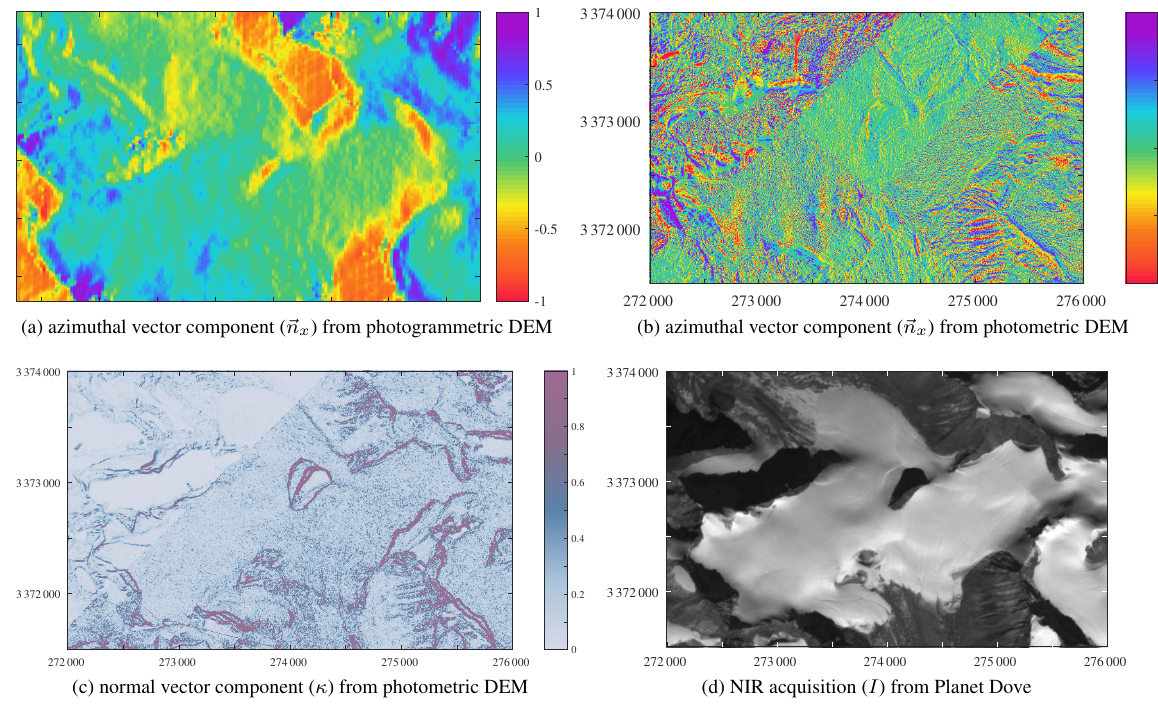
Figure 4. Topographic normals of the photogrammetric DEM (validation), photometric and albedo product (estimate) and acquisition (input) over Zhadang glacier (30.5 ◦ N 90.6 ◦